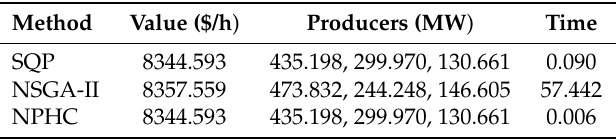
Table 1. Minimization of fuel cost.